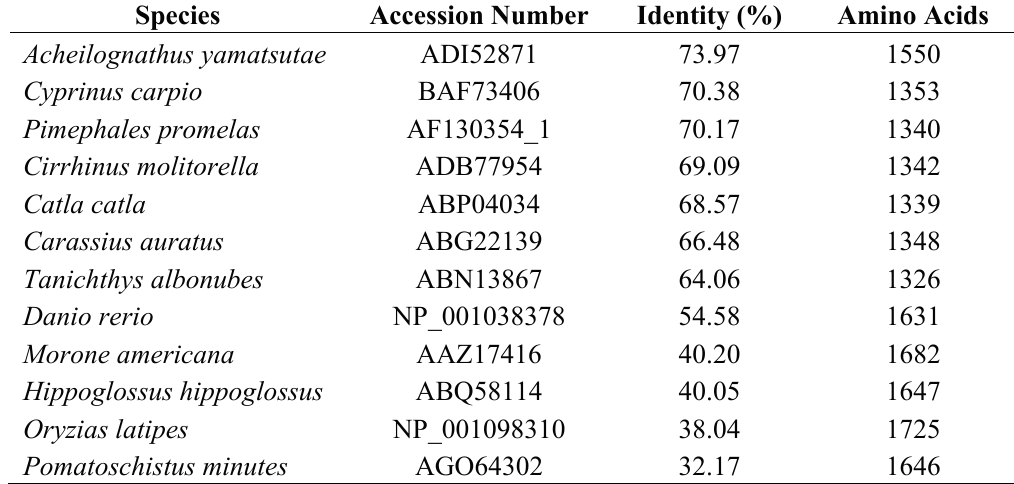
Table 1. Pairwise sequence alignment of Ru-Vg with selected Vg amino acid sequences.